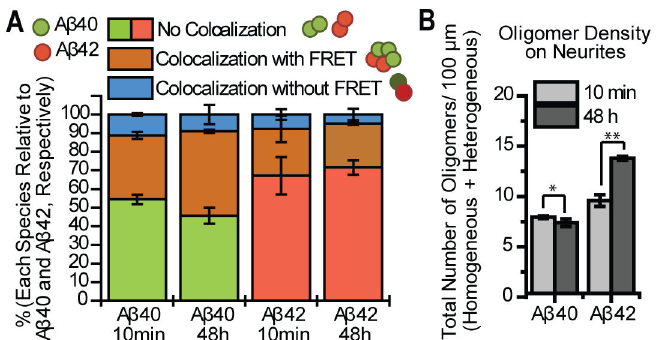
Figure 4. Heterogeneous species increases over time due to continuous binding of Aβ42 to the neurites. 2 nM Aβ40 and 2 nM Aβ42 were mixed and incubated with cultured neurons at the same time. By comparing the population changes of each species, we get general idea of how these species interact over time. (A) The relative number of oligomers of each species in each sample (percentage of each species). The blue shading (colocalization without FRET) represents the co-localized Aβ40 and Aβ42 that do not show a FRET signal. This species accounts for at most 10% for both Aβ40 and Aβ42. The green shaded sections represent the percentage of homogeneous Aβ40 in total Aβ40 species, and show the fraction of homogeneous Aβ40 to decrease over time. The red bar represents the percentage of homogeneous Aβ42 in total Aβ42 species. This number remains almost unchanged over time, indicating the fraction of homogeneous Aβ42 remains unchanged. The brown bar represents the percentage of heterogeneous mixed species in total Aβ40 (left two) or Aβ42 (right two) species. The fraction of heterogeneous species among the whole Aβ40 species increases over time (from 35% to 45%), whereas the fraction of heterogeneous species among whole Aβ42 species remains similar. (B) The density (number of Aβ42 per 100 µm) of Aβ42 oligomers on the neurites (including both homogeneous and heterogeneous species) is slightly higher than Aβ40 at 10 minutes and becomes significantly larger by 48 hours, whereas the total number of Aβ40 is only slightly changed (unpaired two-tailed t-test, *P > 0.1 and **P < 0.05). Data was averaged from two different experiments, at least 5 images each and each image contained at least 50 oligomers. Error bars represent standard deviation of the mean. Figure 5 provides a pictorial display of the